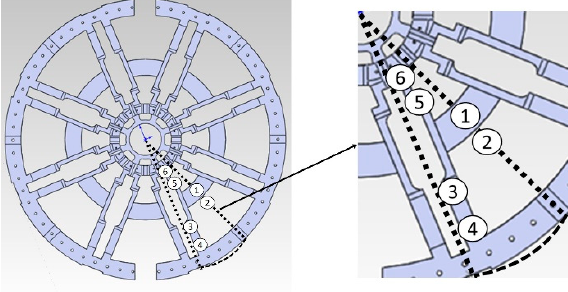
Figure 10. Temperature sensors positioning on the surface of the MCW. Sensors 1 and 2 were placed on the top and bottom surface of the MCW, respectively.